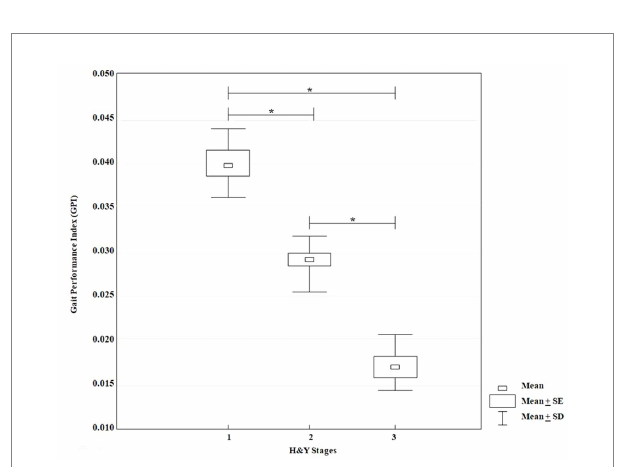
FIGURE 5 KW-ANOVA, demonstrating differences in the GPI scores between groups 1 and 2, 1 and 3 and between groups 2 and